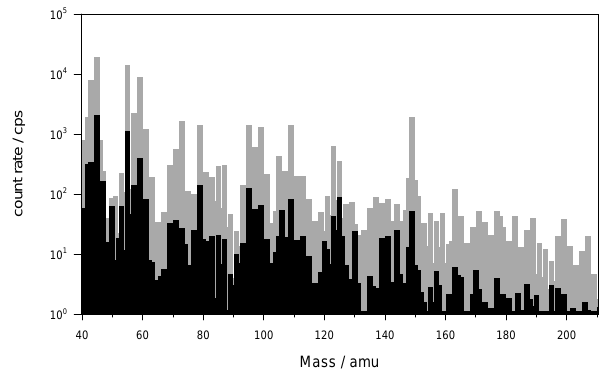
Fig. 3. Instrumental background mass spectrum of the HT-PTR- MS recorded after start-up (grey) and after one-week of continuous operation (black); both mass spectra were recorded at an HT-PTR- MS operational temperature of 200 ◦